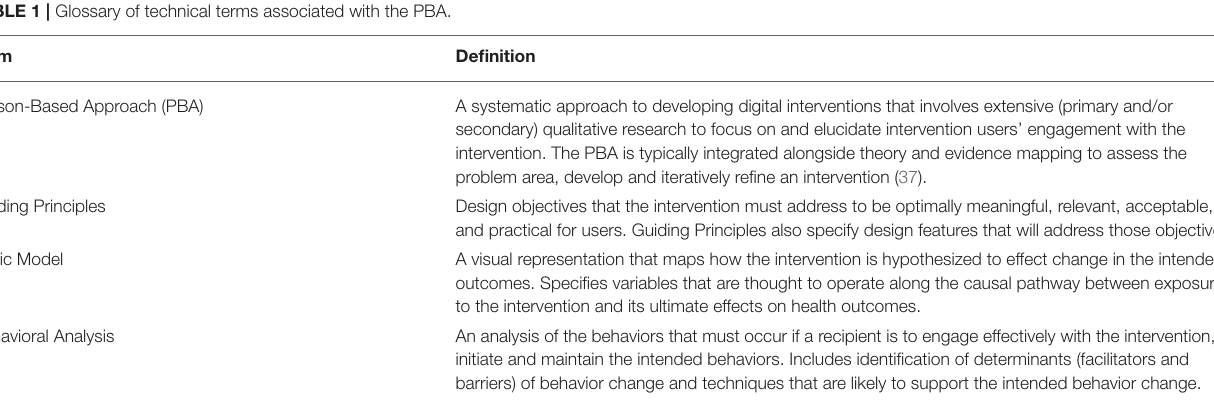
TABLE 1 | Glossary of technical terms associated with the